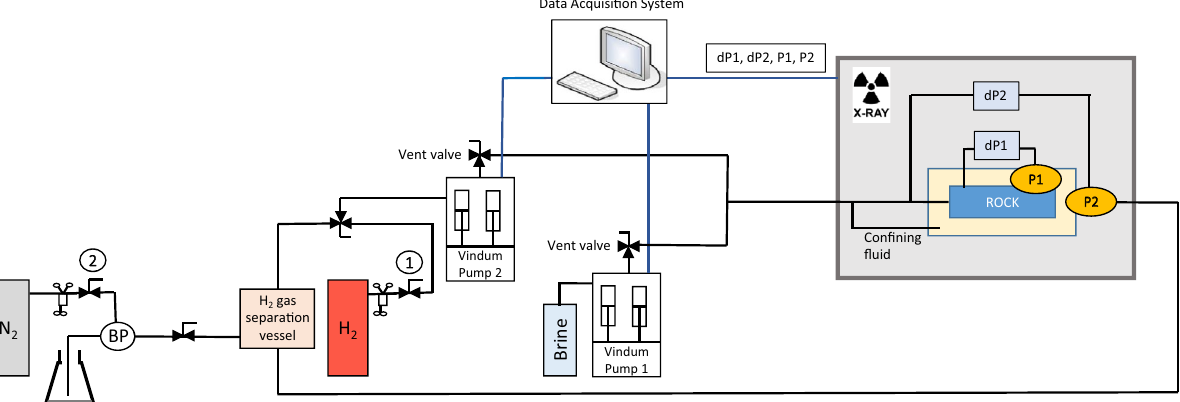
Figure 2. Schematic of experimental